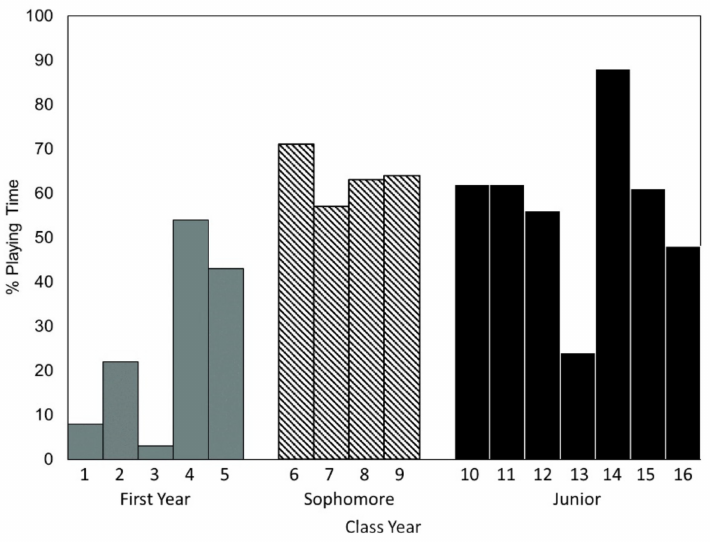
Figure 1. Percentage of total on field playing time for each athlete, grouped by class year. Pre season and post season average values of body mass, percent body fat, vertical jump, and Yo-Yo IR1, for each class year are presented in Table 1. There was a significant main effect of session (F 1,13 = 9.640, p = 0.008, η p2 = 0.426) and class year (F 2,13 = 92.950, p < 0.001, η p2 = 0.935) and a significant interaction effect (F 2,13 = 4.074, p = 0.042, η p2 = 0.385) on body mass (Table 1). There was a significant main effect of class year (F 2,13 = 129.665, p < 0.001, η p2 = 0.952), but no significant effect of session (F 1,13 = 3.755, p = 0.075, η p2 = 0.224) or interaction (F 2,13 = 1.610, p = 0.237, η p2 = 0.199) on percent body fat. First-year athletes mass: p < 0.001, percent body fat: p < 0.001) and juniors (body mass: p < 0.001, percent